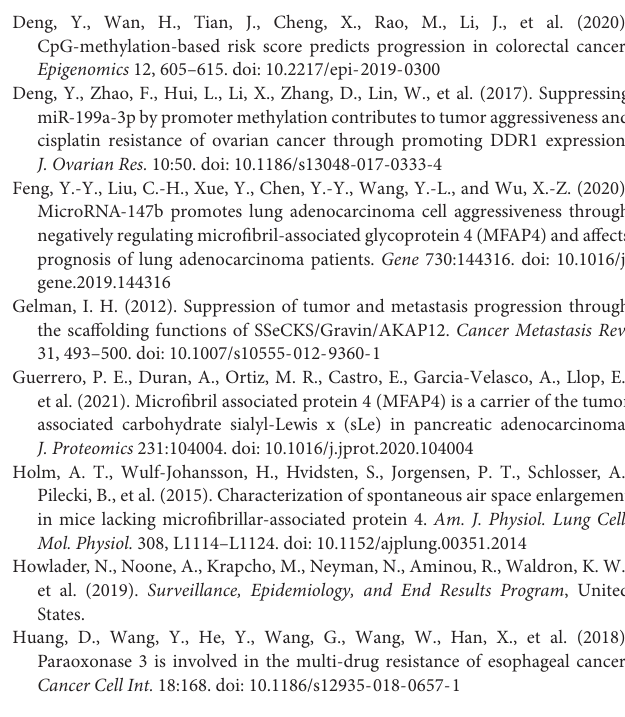
Supplementary Figure 1 | Subgroup analysis of the survival of patients with different clinicopathological characteristics. (A) Age, (B) tumor status, and (C) FIGO stage. Supplementary Figure 2 | Kaplan–Meier (KM) survival curves of joint analysis of methylation and expression data in OC. Supplementary Figure 3 | Functional enrichment analysis of the differentially expressed genes (DEGs) between the high-risk and low-risk groups. (A) Top 10 most enriched Gene Ontology (GO) terms of these genes. (B) Top 20 most enriched pathways of these